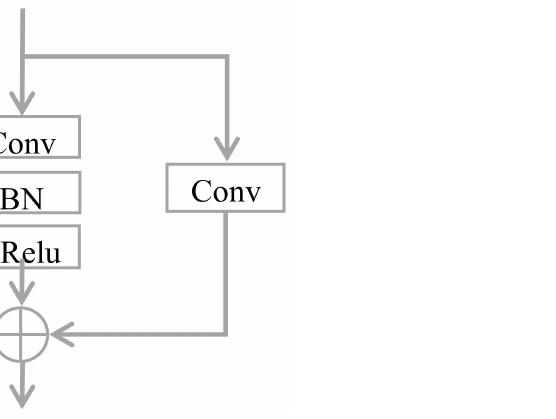
Figure 4. Structure of RES. Conv: convolution operation. BN: regularization. PRelu: activation